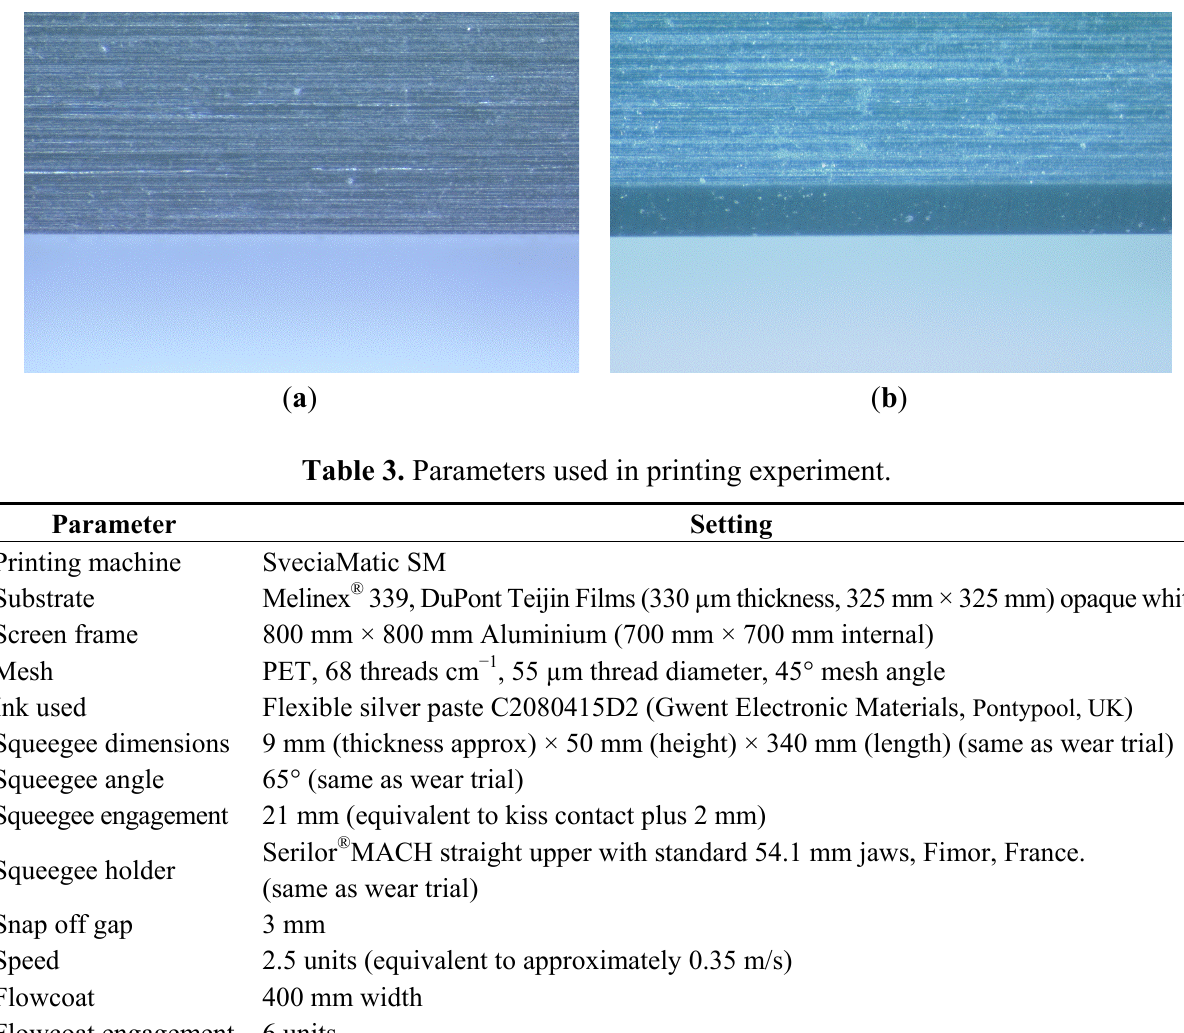
Figure 4. Microscope images of squeegee edge ( a ) before and ( b ) after wear. Images 3.84 mm × 2.46 mm.